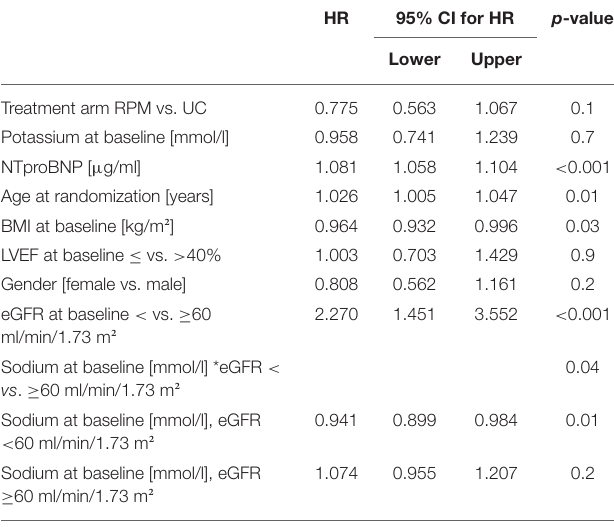
HR 95% CI for HR p -value Lower Upper